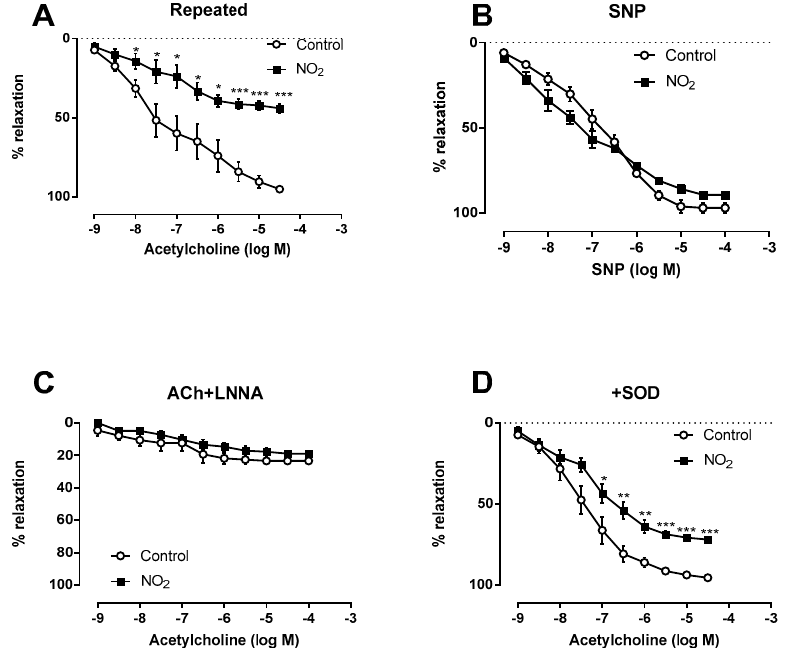
Figure 6. Coronary function after repeated NO 2 exposures. Coronary function was assessed at 1-day post-exposure after 3 weeks (3 h / day, 5 days / week) of NO 2 exposures. Vasorelaxation induced by acetylcholine ( A ) or sodium nitroprusside (SNP) ( B ), or acetylcholine after preincubation with either NG-nitro-L-arginine (Ach + L-NNA) ( C ) or superoxide dismutase ( + SOD) ( D ) of isolated coronary arteries from control (open circles) or NO 2 -exposed rat (solid squares). * p < 0.05, *** p < 0.001 vs. control.